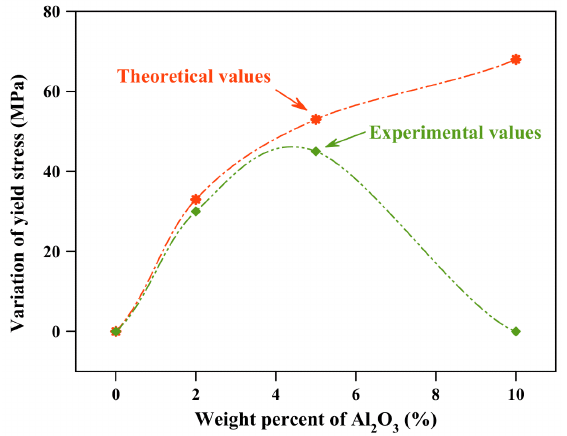
Figure 7. Comparison of the strengthening effect in the as-extruded Al-12Si/Al 2 O 3 nanocomposites between experimental observation and calculated theoretical values.